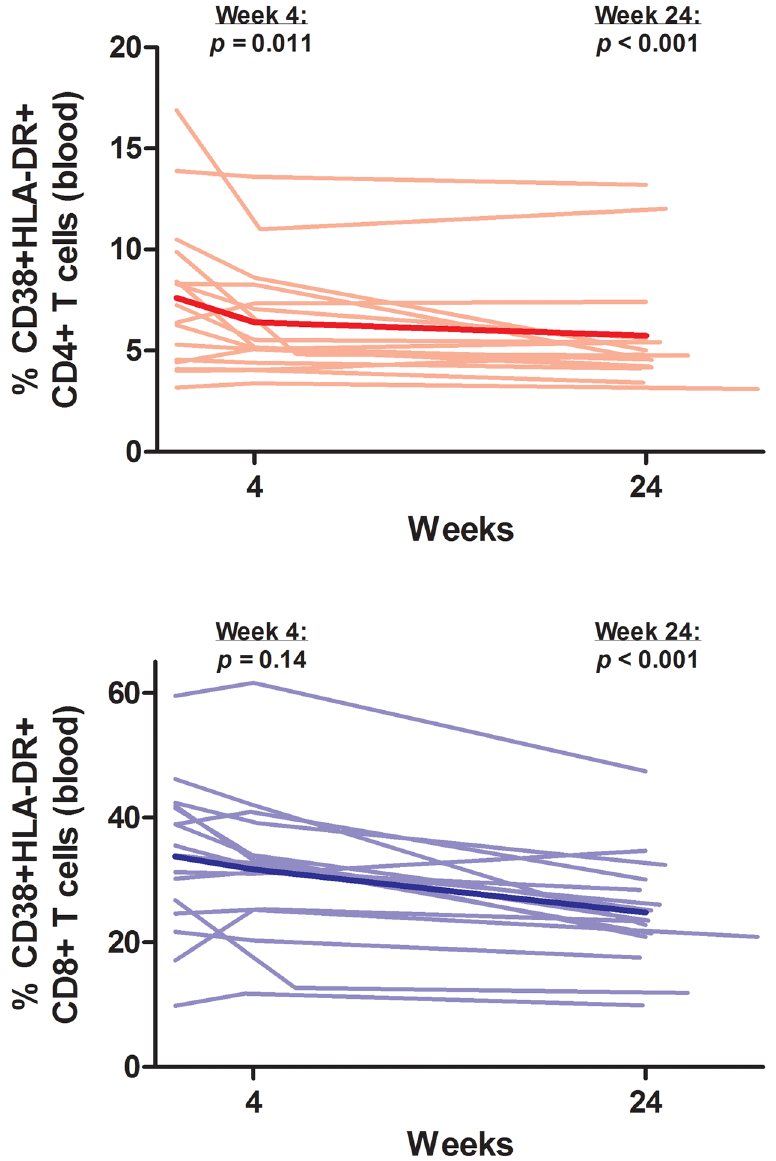
Figure 5. Change in T cell activation in peripheral blood. Thin lines indicate data for each individual subject. The thick line indicates the estimated mean value over time from mixed effects linear regression. P-values refer to change from baseline at each referenced